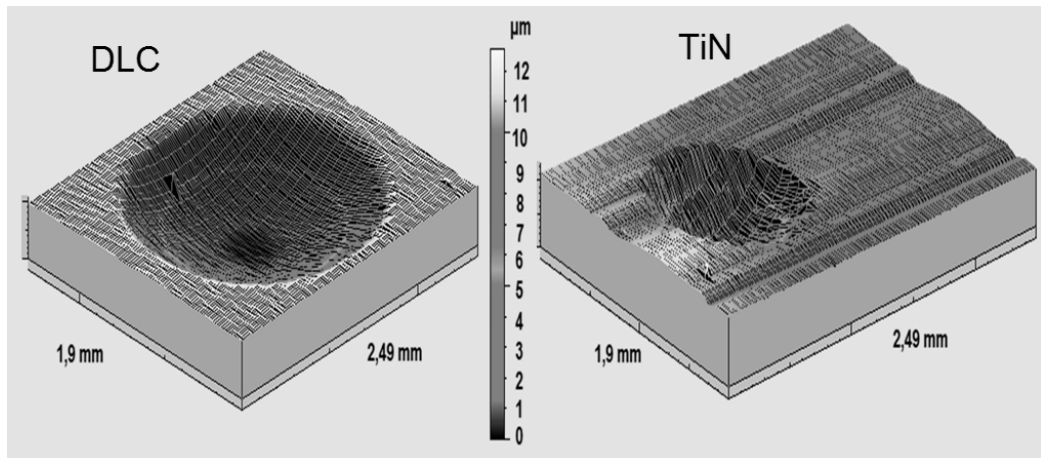
Figure 7. Crater profile of DLC and TiN by